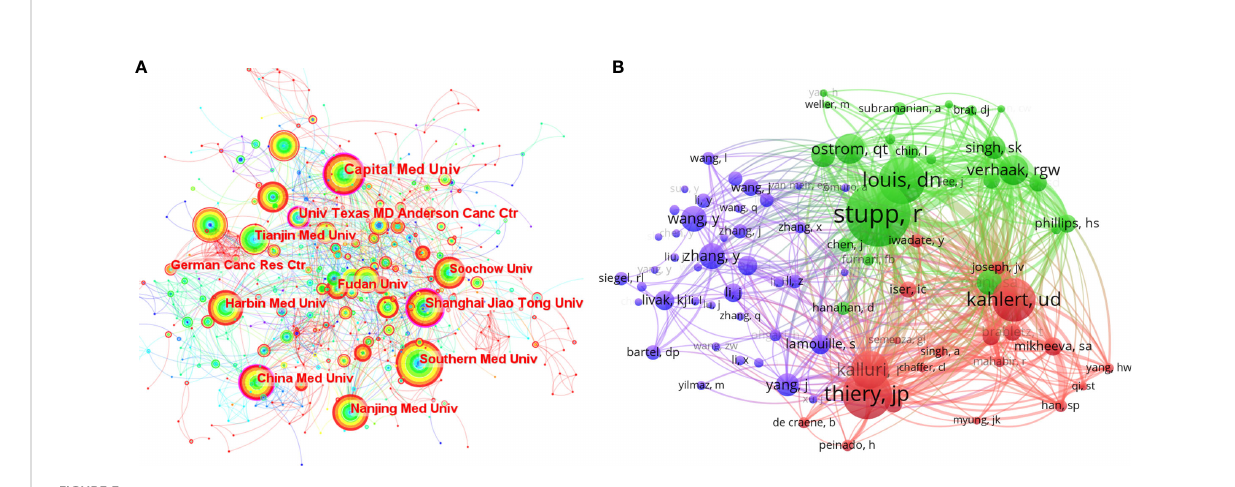
FIGURE 3 (A) The collaborative network of the research institutions. (B) The collaborative network of co-cited